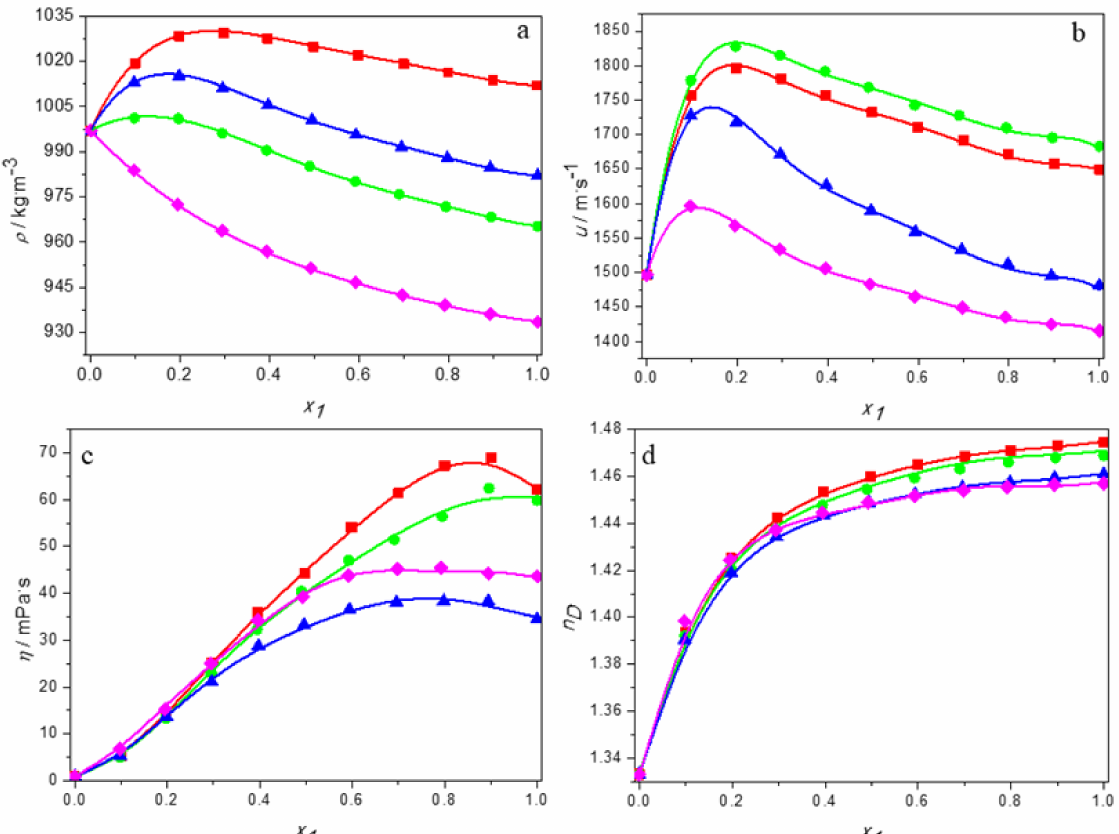
Figure 1. The dependence of the physical properties of aqueous solutions of DESs on molar fraction of deep eutectic solvent at 298.15K: ( a ) density; ( b ) speed of sound; ( c ) viscosity; ( d ) refractive index. (cid:4) DES1; • DES2; (cid:78) DES3; (cid:7) DES4; —, Equation